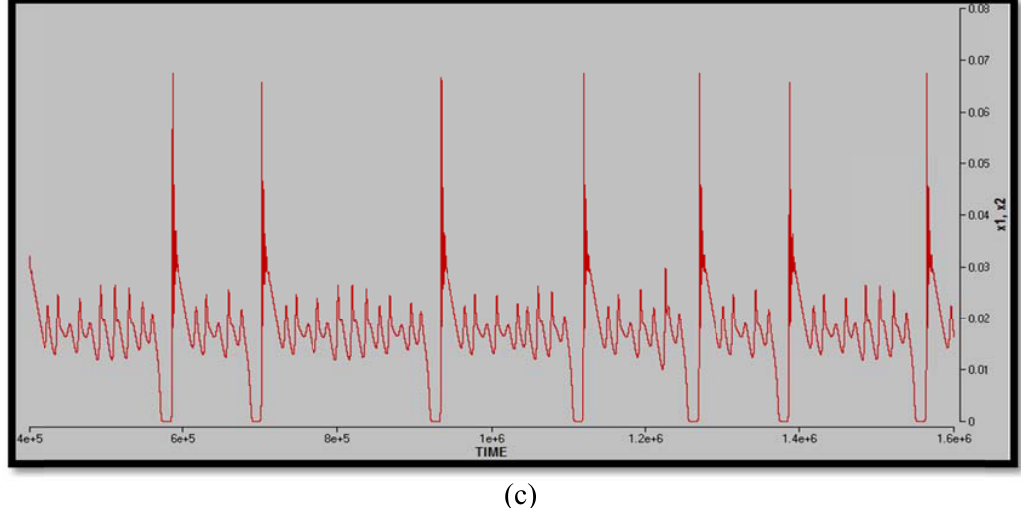
between two oscillators,